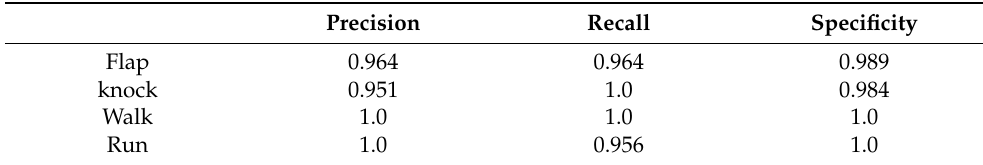
Table 2. Performance evaluation